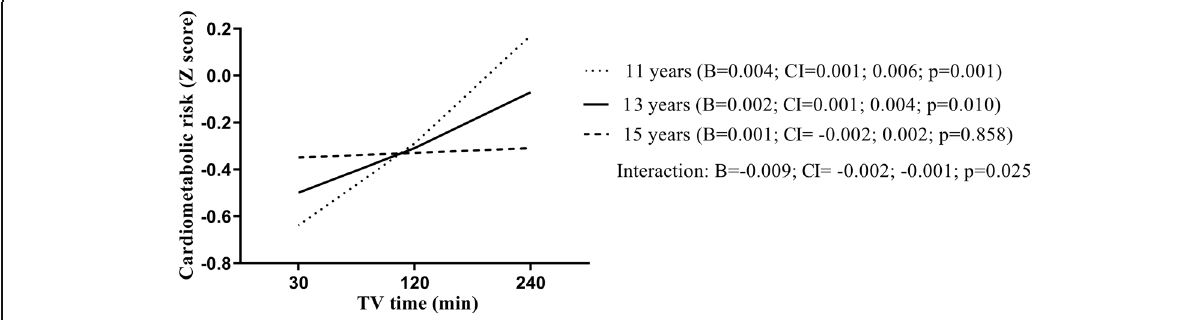
Fig. 2 Age as a moderator in the relationship between TV time and cardiometabolic risk. TV, television; β , linear